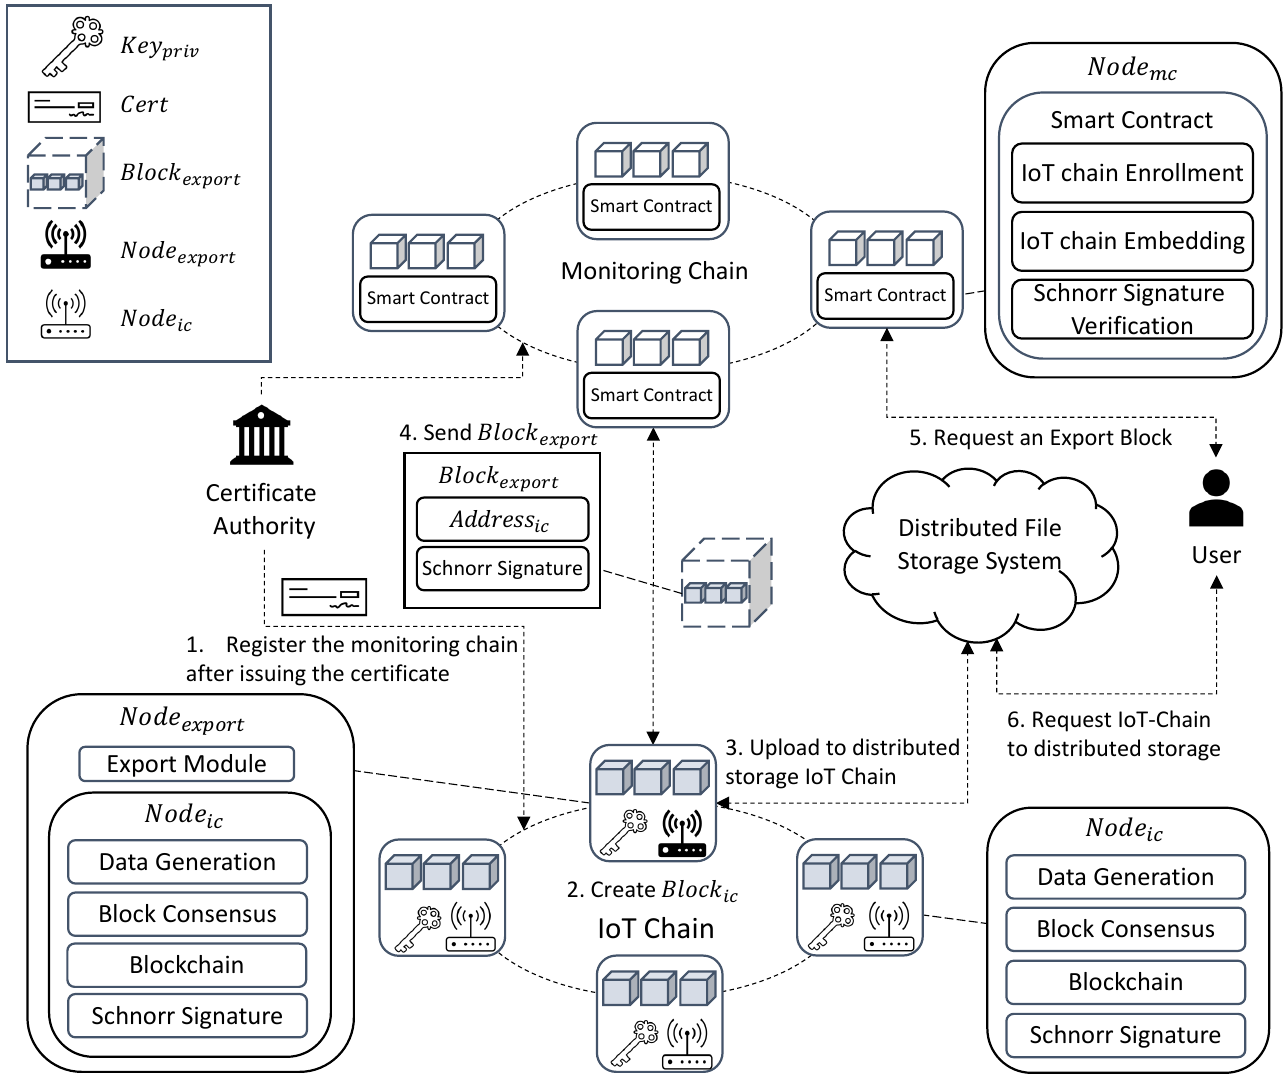
Figure 2. System Architecture: ( 1 ) All Node ic register their identity through CA and then participate in the network and register the IC by storing the Genesis Block hash value in the MC . All IoT-Chain nodes must obtain a key through CA and register a certificate for the public key. In ( 2 ) Network ic , Nodeic generates the sensor data, Block ic is generated, and the length of the IC increases. ( 3 ) To maintain the IC at no more than a certain size (storage capacity of IoT device), Node export is